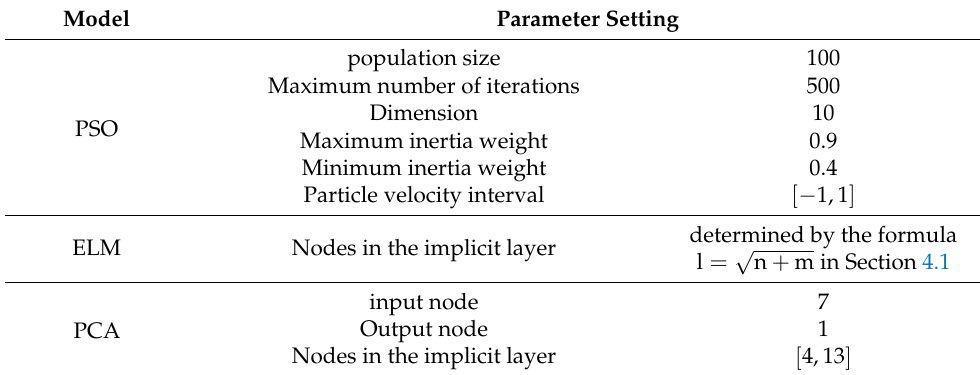
Table 7. Model parameter setting.